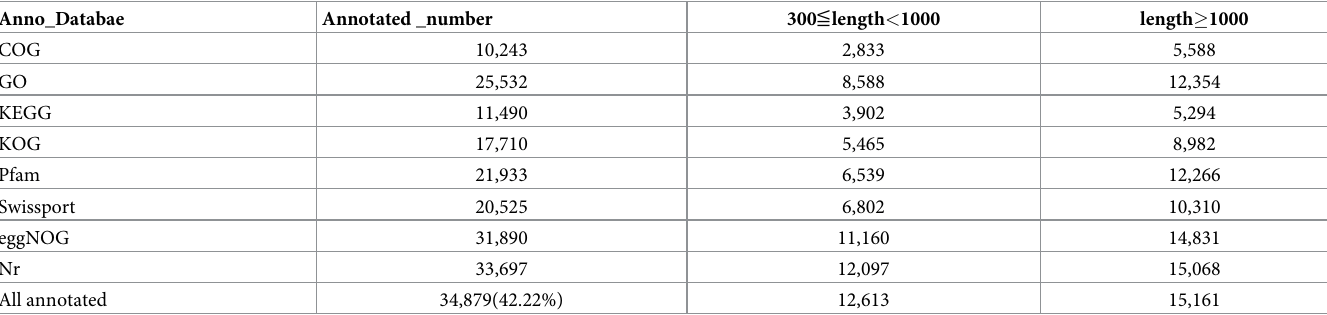
Table 3. Number of unigenes blasted to databases (E <